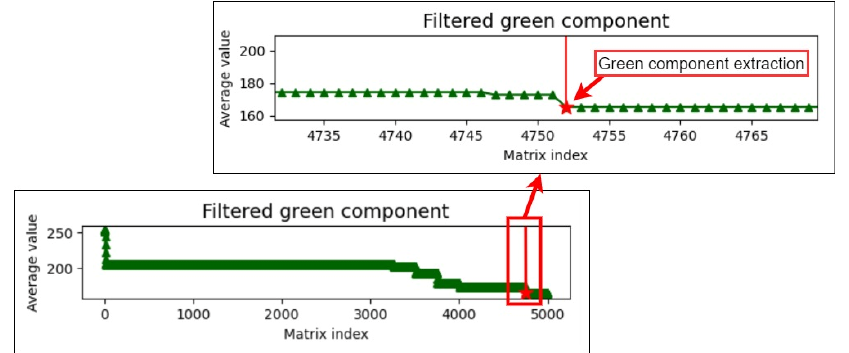
Figure 20. Upper limit extraction for the green component.